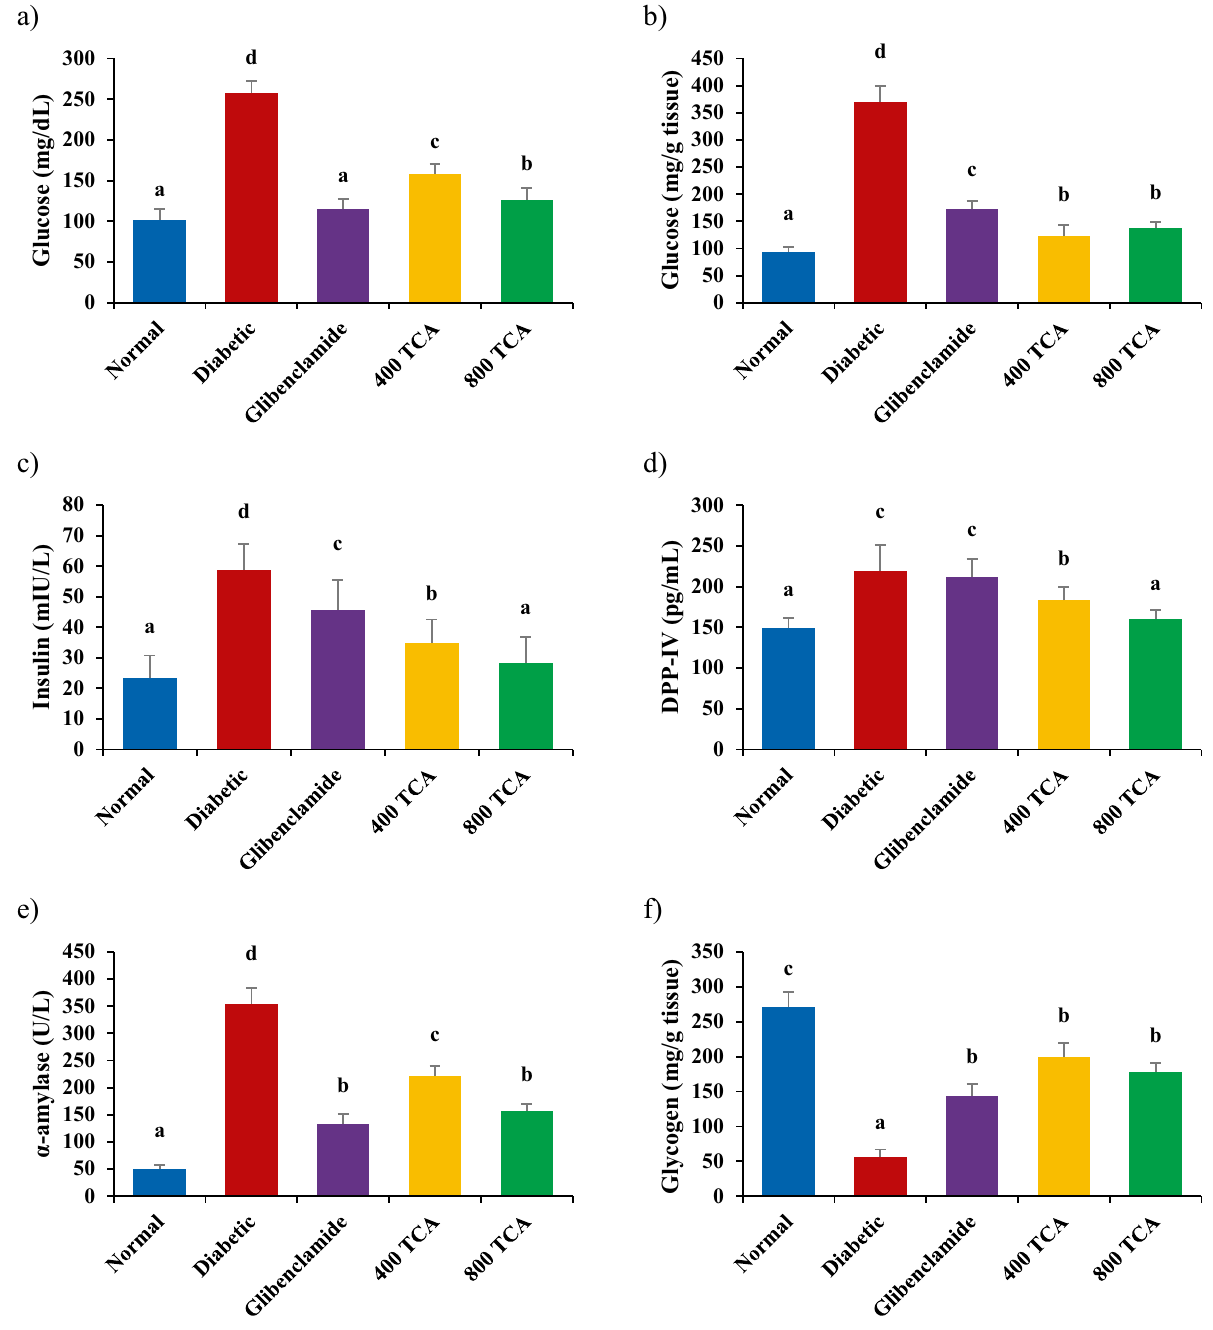
Figure 5. Effect of T. catappa aqueous extract treatment on ( a ) plasma glucose, ( b ) liver glucose, ( c ) plasma insulin, ( d ) plasma dipeptidyl peptidase IV, ( e ) plasma α-amylase, ( f ) hepatic glycogen, ( g ) triglyceride, ( h ) plasma protein and ( i ) hepatic protein in HFD/STZ-induced diabetic rats. Bars are expressed as mean ± SEM (n = 6). Bars with different superscripts are significantly different, while those with similar superscripts are not significantly different at p <